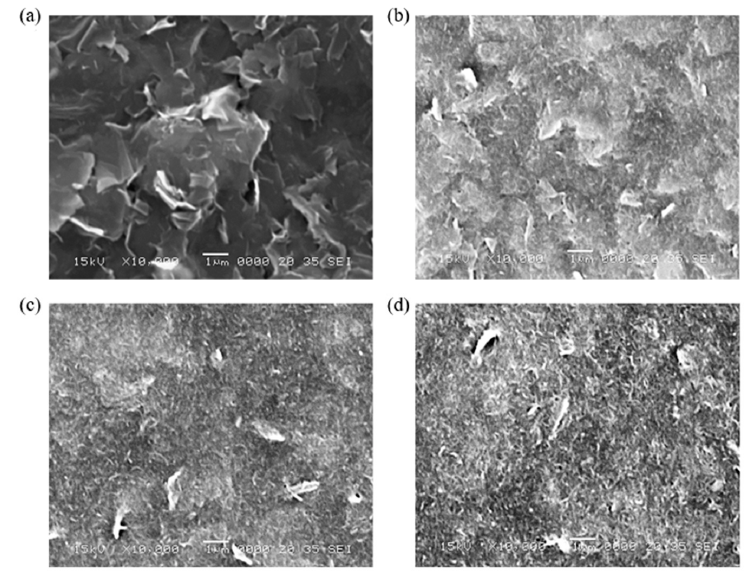
Figure 4. SEM images of ( a ) chemically-modified graphene (CG), ( b ) CG / carboxylic-functionalized multiwalled carbon nanotubes (f@MWCNTs)-15% composite, ( c ) CG / f@MWCNTs-25% composite, and ( d ) CG / f@MWCNTs-35% composite.